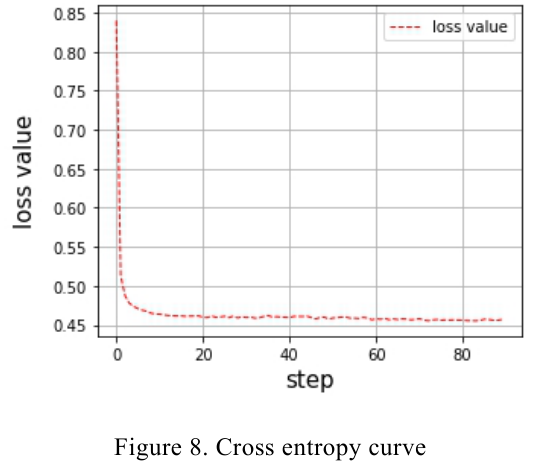
Figure 8. Cross entropy curve